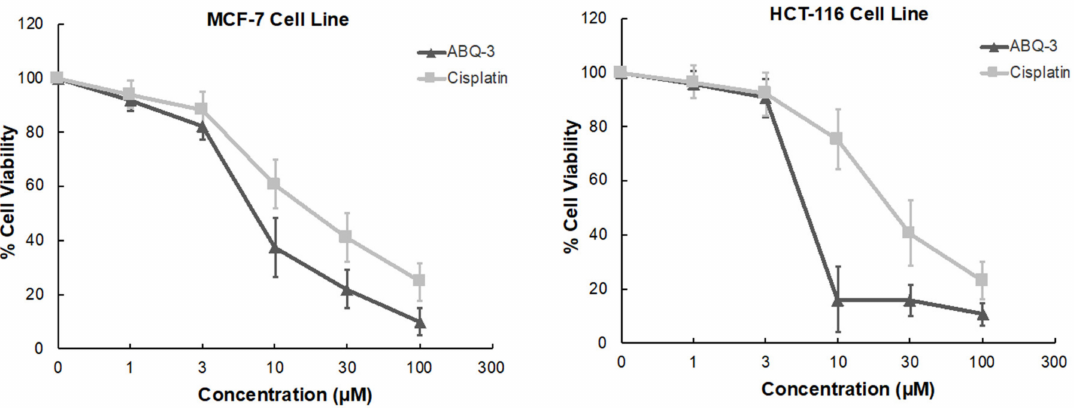
Figure 5. The cytotoxicity of ABQ-3 at varying concentrations on breast cancer and CRC cells compared to